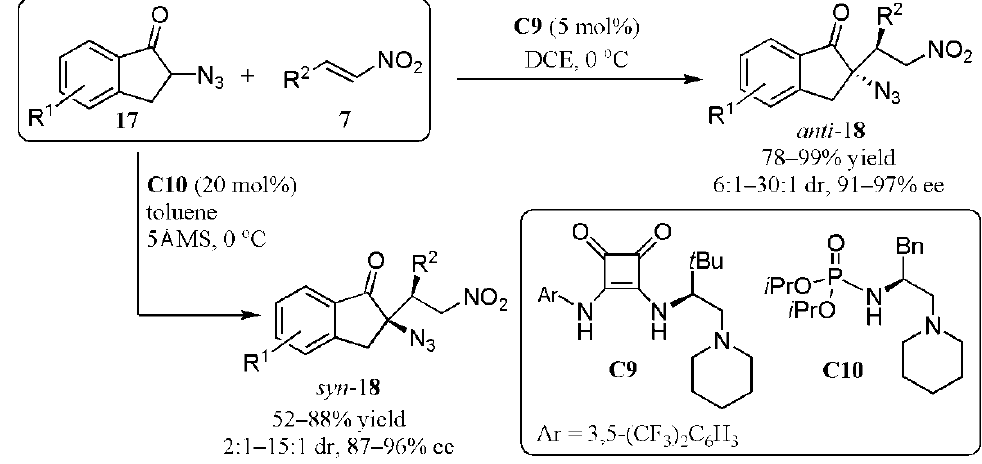
Figure 12. Stereodivergent Michael addition of α -azido ketones 1 7 to nitroolefins 7 [32].